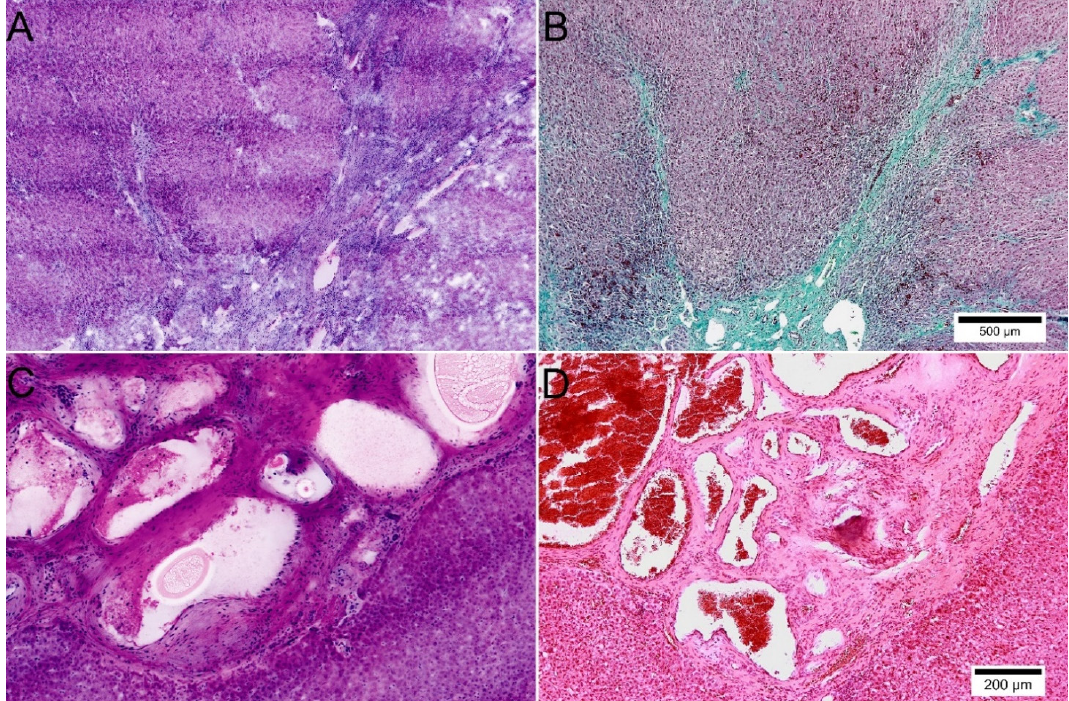
Figure 3. Representation of benign primary tumors and masses of the liver in FCM scans. ( A , B ): Focal nodular hyperplasia in FCM ( A ) and conventional histology with special staining (( B ), Masson’s trichome). Note the radial scar and fibrous septa are well represented in FCM. ( C , D ): A case of hemangioma in FCM ( C ) and conventional histology (( D ), HE staining). Good representation of vessels and a fibrous matrix in the FCM scans. Note the lining of unsuspicious endothelial cells in FCM.